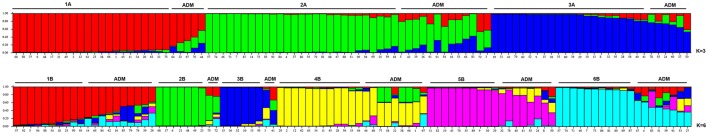
Structure classification at K = 3 and K = 6 of the 95 entries of Pyrus spp. The clusters are marked with different colors, while the accessions at P of (qI) ≤ 0.80 are grouped as Admixture (ADM).